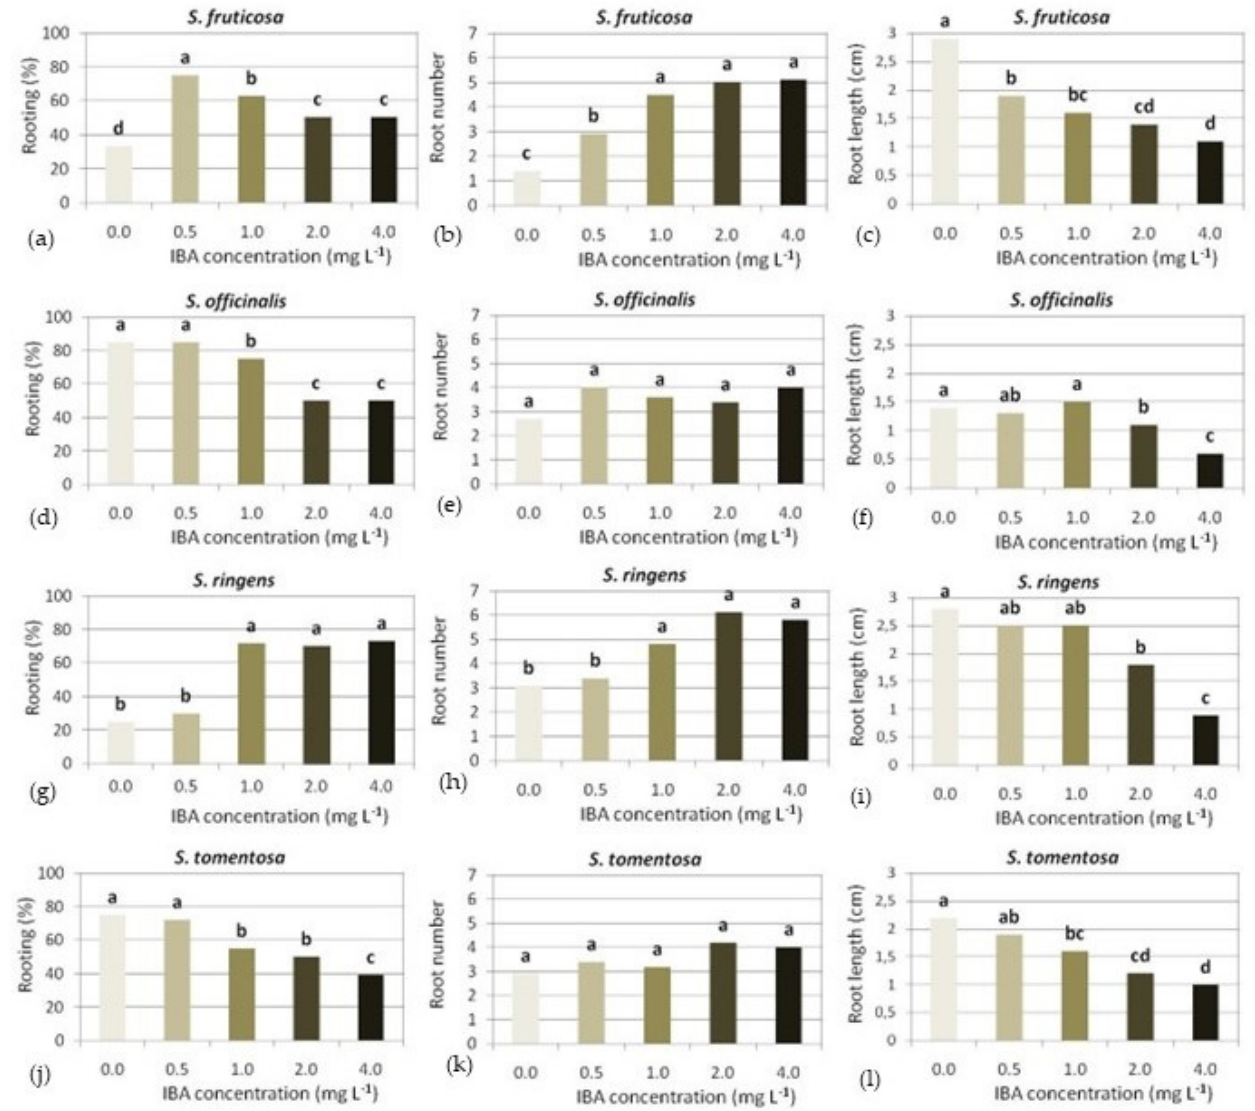
Figure 11. Effect of IBA concentration on in vitro rooting of marked Salvia spp. microshoots, on 1 / 2 MS medium supplemented with indole-3-butyric acid (IBA) concentration marked ( n = 15–30).